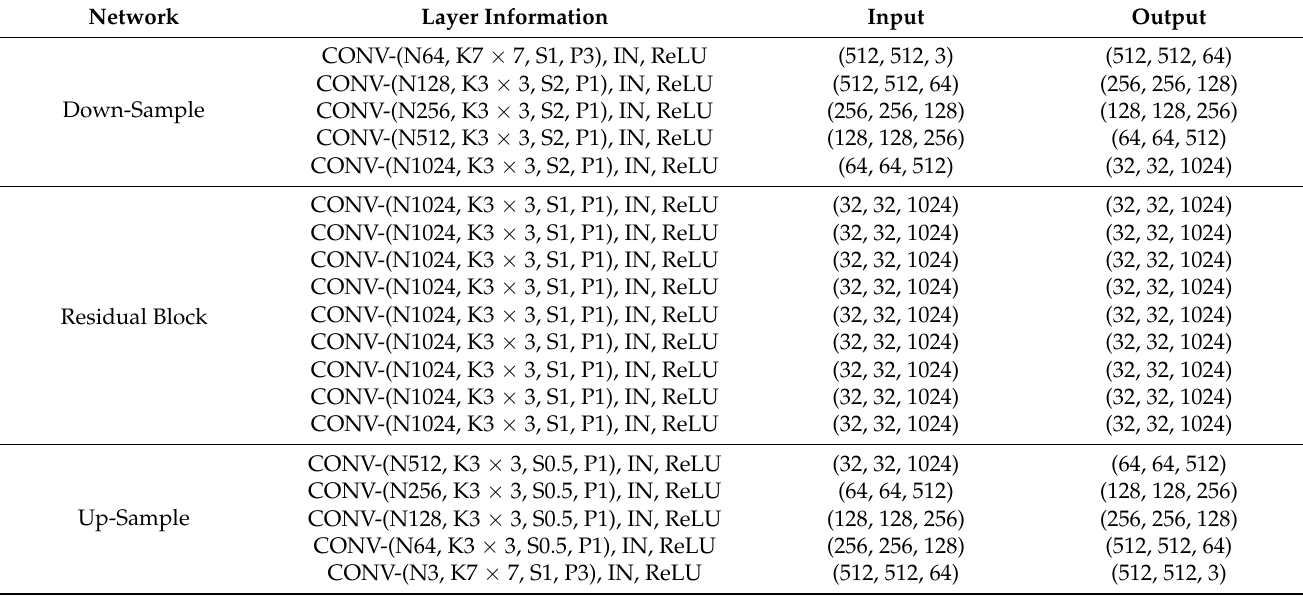
Table 1. The architecture of the generator.